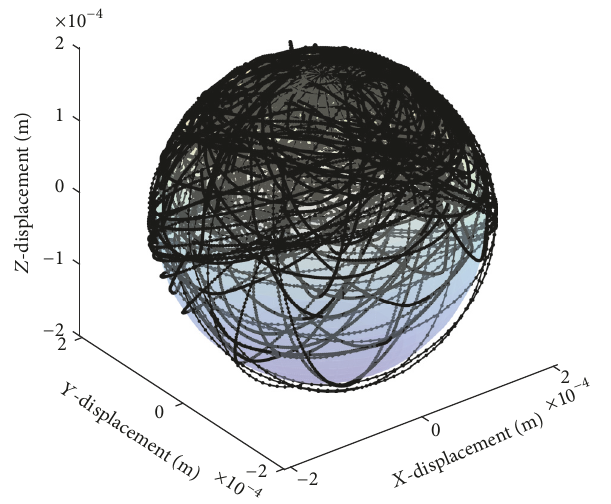
Figure 12: Trajectory of the ball center.